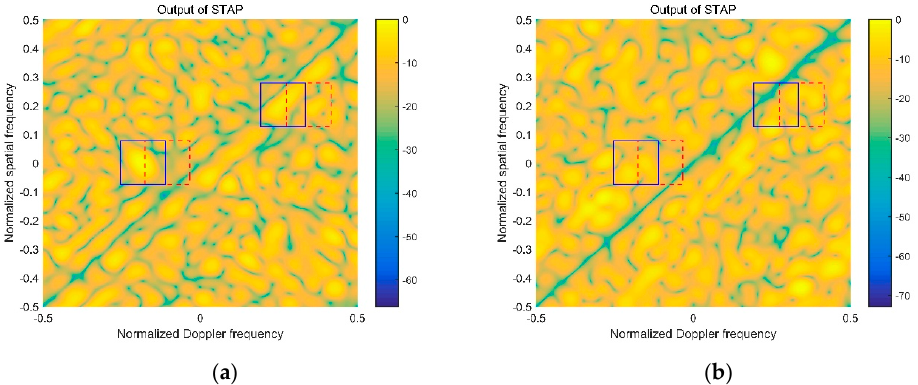
Figure 6. STAP output of 670th range bin: ( a ) Full STAP before equalization; ( b ) full STAP after equalization.